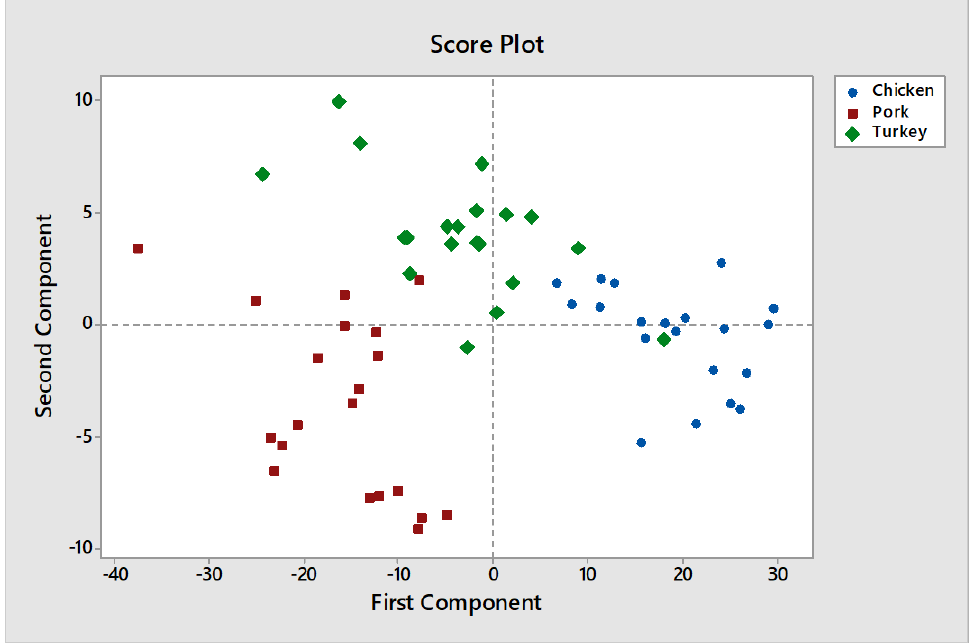
Figure 11. PCA score plot of chicken, pork and turkey.